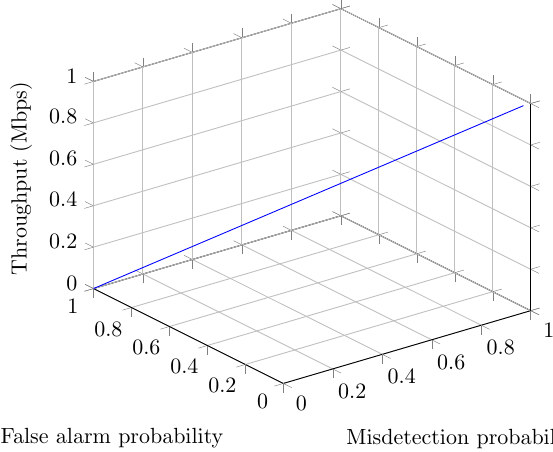
Figure 9. Throughput vs. hidden PU activity rate.